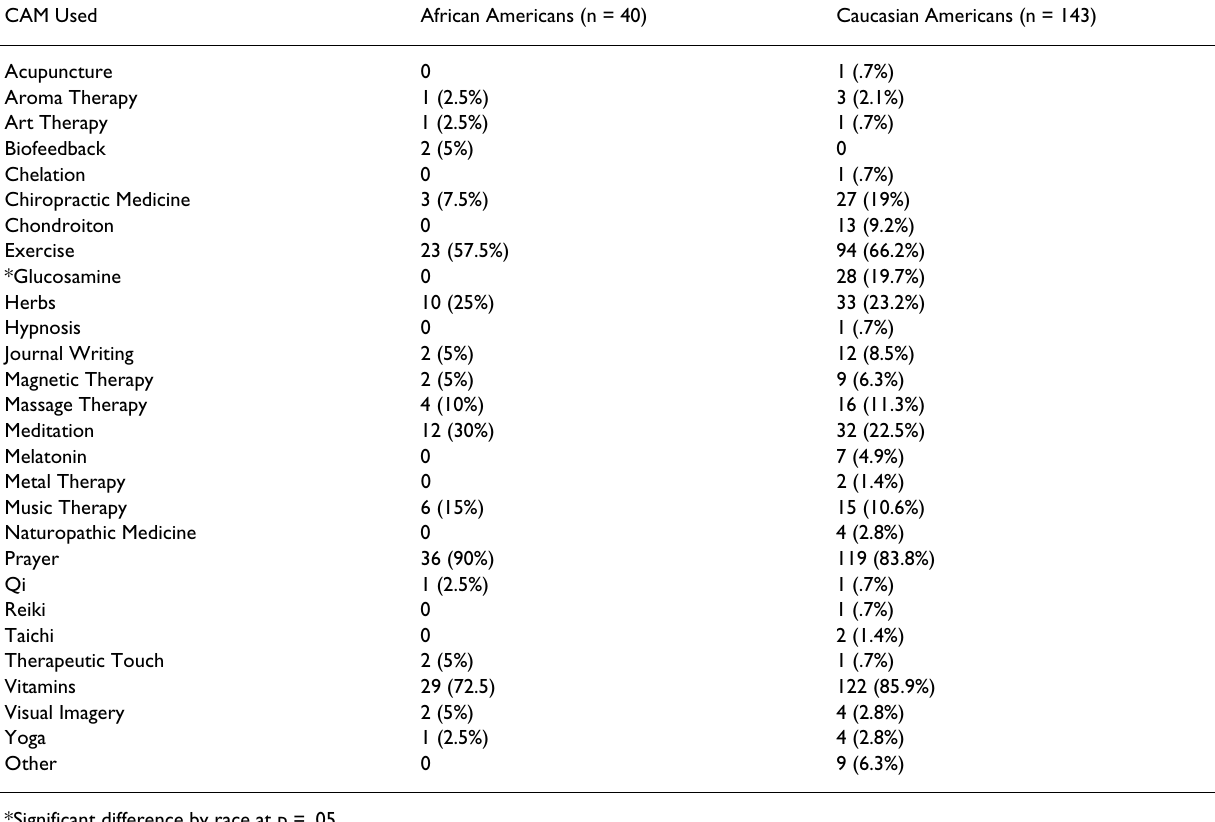
Table 2: CAM use by AA and CA Rural Older adults CAM